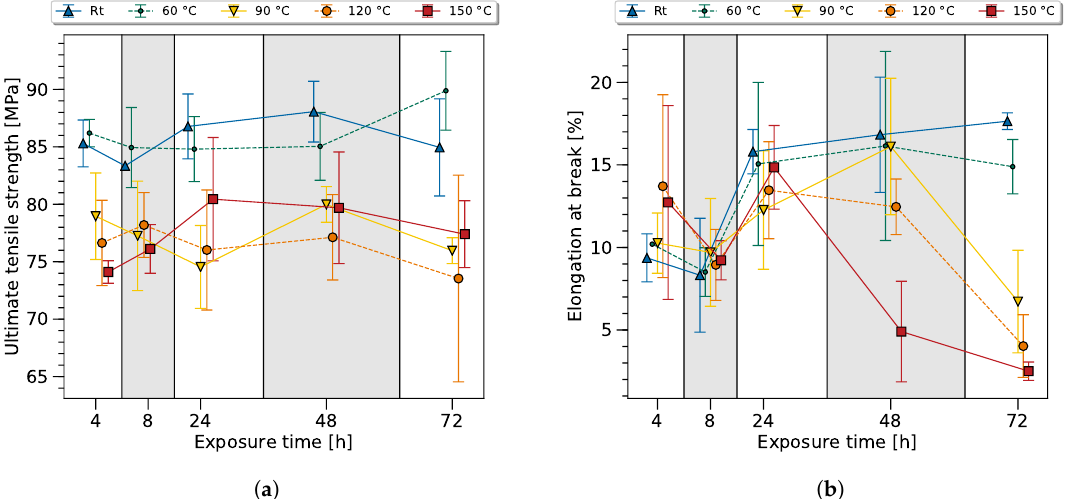
Figure 3. Ultimate tensile strength (UTS) ( a ) and elongation at break (EB) ( b ) after thermal exposure for 4–72 h at 20 °C, 60 °C, 90 °C, 120 °C, and 150 °C. Table 2. UTS in MPa with standard deviation in